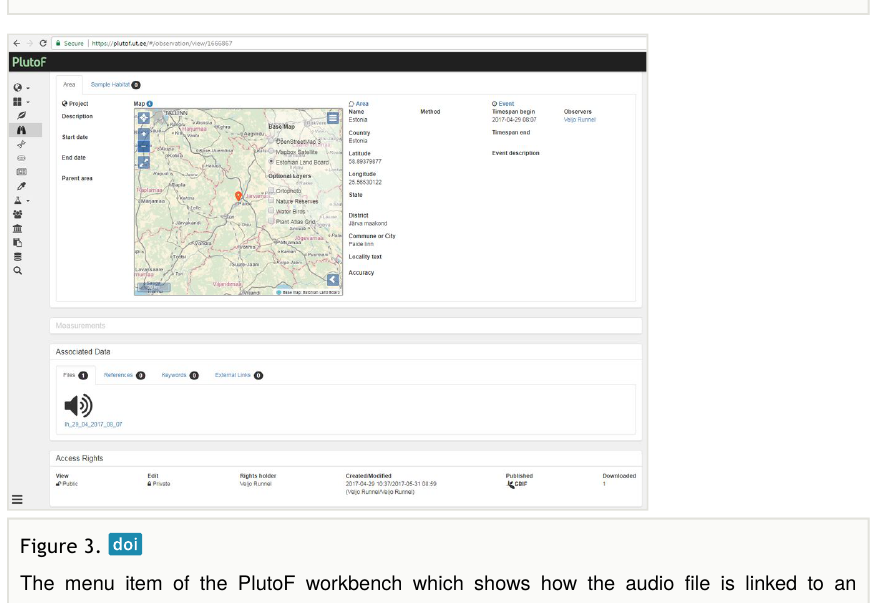
The search window of PlutoF workbench for Parus major observations with the audio fi les attached.